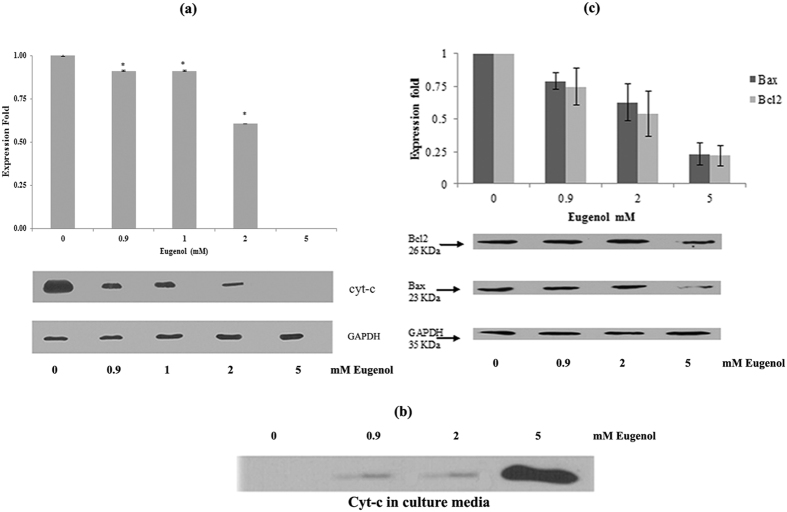
(a) Effect of eugenol on expression of cyt-c in MCF-7 treated cells (b) Eugenol induces release of cyt-c in culture media; and (c) expression of anti- and pro-apoptotic proteins in eugenol-treated MCF-7 cells. Results of densitometry of bands in cropped gels are expressed as mean expression ratio relative to control and are normalized relative to the internal control expression of GAPDH. Each value represent mean ± SEM of nine determinations from three different experiments; *P value < 0.05 was considered significant.